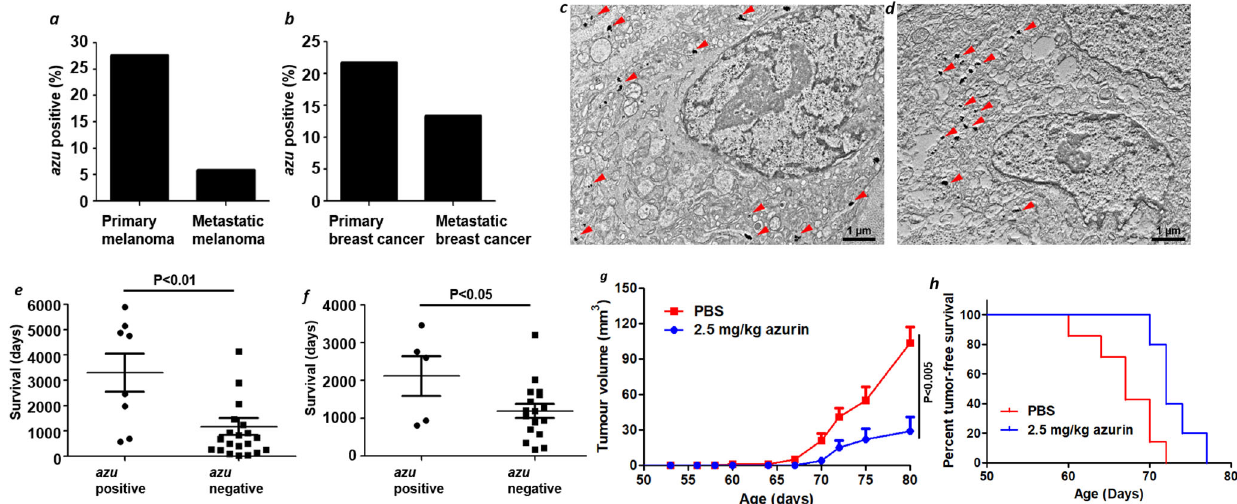
Fig. 4 Azurin-producing P. aeruginosa in human tumors. The azurin-encoding gene ( azu ) was detected in tumors from patients with breast cancer and melanoma. It was ampli fi ed by PCR with P. aeruginosa azu -speci fi c primers and con fi rmed by DNA sequencing. The ampli fi ed PCR product, as a single band, was sequenced and showed 100% identity to P. aeruginosa azu . In melanoma ( a ), 27.6% (8 of 29) of primary tumors and 5.9% (2 of 34) of metastatic tumors were azu positive ( P < 0.05). In breast cancer ( b ), 22.7% (5 of 22) of primary tumors and 14.3% (2 of 14) of metastatic tumors were azu positive ( P > 0.05). In addition, frozen tumor samples were processed for immunogold transmission electron microscopy (TEM) by using anti- P. aeruginosa and anti-azurin antibodies. TEM images of uranyl acetate-stained sections (arrowheads) showed the intracellular localization of P. aeruginosa ( c ) and its product azurin ( d ) in human melanoma sections that were azu positive by PCR. Magni fi cation: ×3000. e , f Patients with azu-positive tumors displayed increased survival. Survival analysis of patients with azu -positive vs. azu -negative primary melanoma ( e , P < 0.01) and primary breast cancer ( f , P < 0.05) tumors. g Hemizygous MMTV-PyMT transgenic mice were injected with either PBS control or 2.5 mg/kg azurin (intraperitoneally, 3× weekly) for 2 months. The mean + SE values of tumor volume were calculated. h Tumor-free survival curve was generated with the PBS control and 2.5 mg/kg azurin groups of MMTV-PyMT transgenic mice. Median tumor-free survival of the PBS control and azurin-treatment groups was 67 and 72 days, respectively. P =